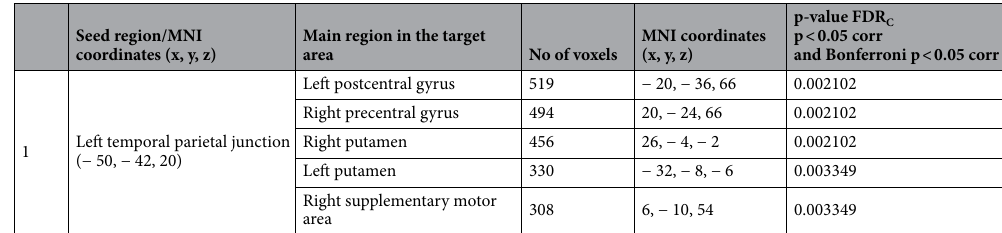
Table 1. Resting-state functional connectivity found correlated positively with the temporal order threshold (TOT) values in all participants (n = 65) after controlling for gender. The Montreal Neurological Institute (MNI) coordinates for the center position of the seed are placed in the bracket, right after the seeds’s name, whereas the MNI coordinates of the peak voxel of each target region are in a separate column. The relationships were significant (mass p-value FDR C , p < 0.05) with Bonferroni correction for multiple comparisons (p < 0.05).